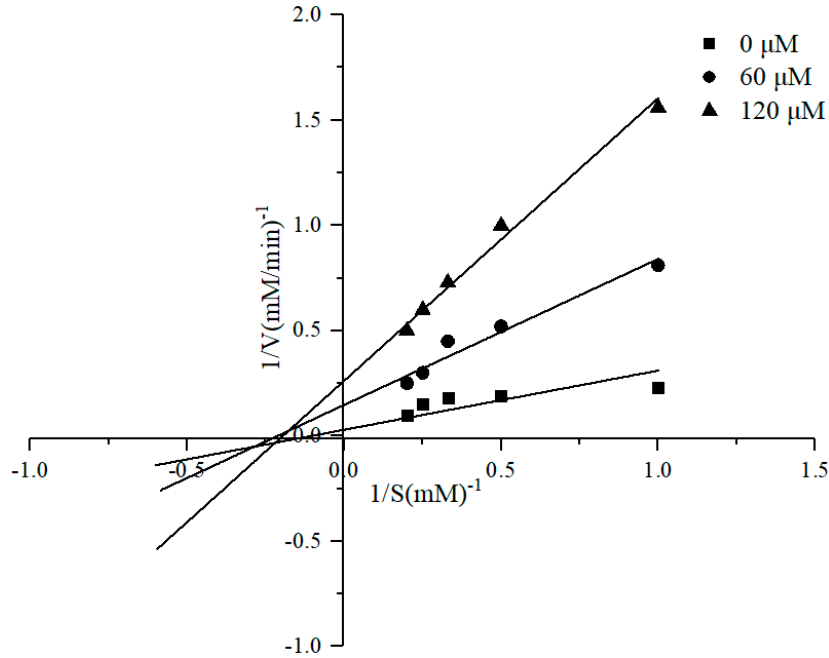
Figure 5. Lineweaver − Burk plots of ACE inhibition by the DLTAGLLE peptide.